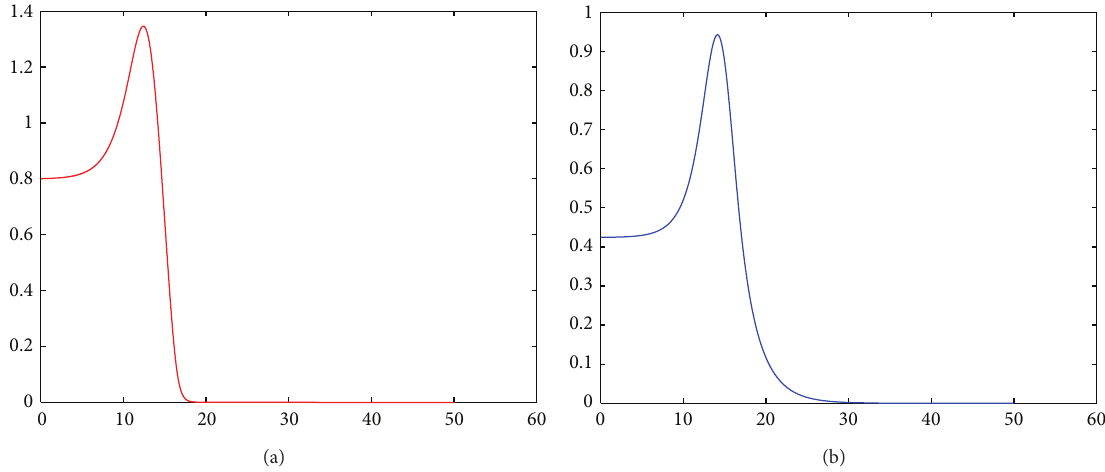
Figure 1: Time evolution of (4) around (0, 0) . Phytoplankton is in (a) and zooplankton is in (b). The parameter values are 𝑑 1 = 0.001 , 𝑑